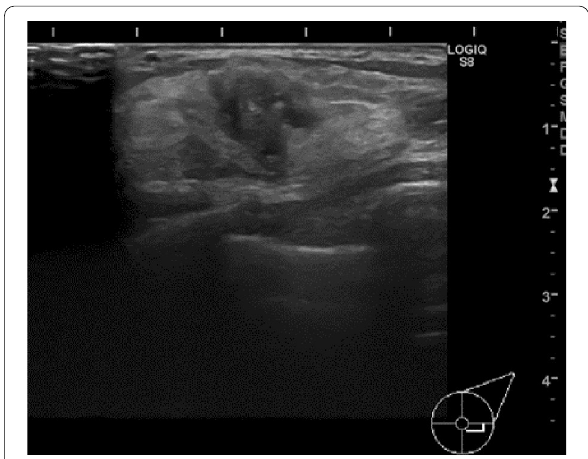
Fig. 2 Breast ultrasonography. A 1.3 hypoechoic mass with angular margin mass was found in the lower outer quadrant of the left